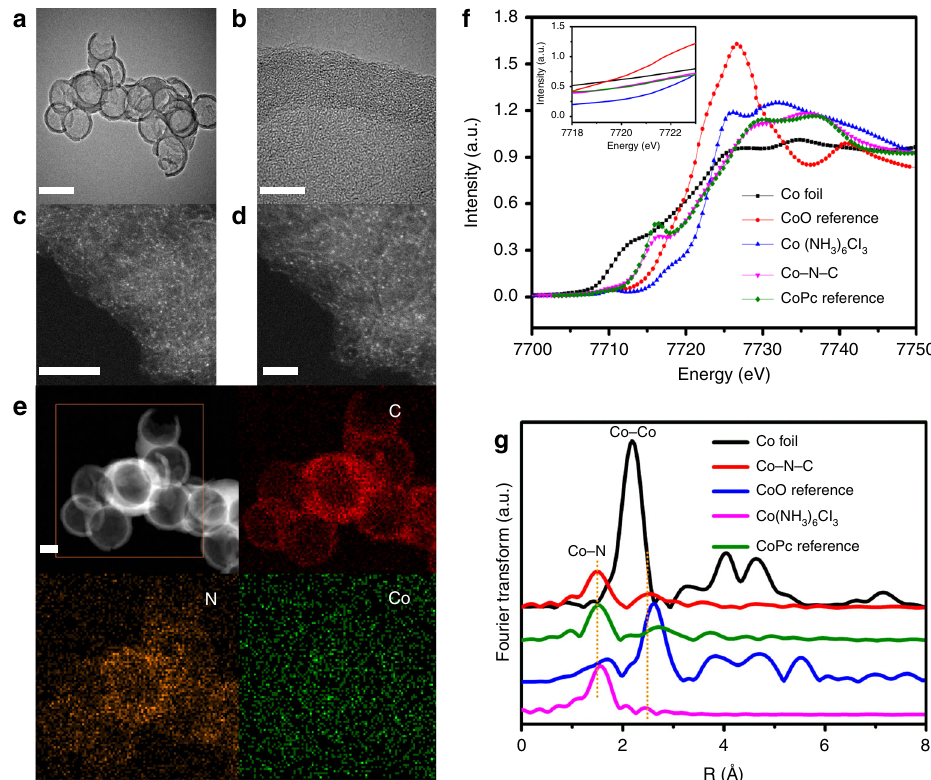
Fig. 1 Physical characterization. a TEM, scale bar: 200 nm; b HR-TEM, scale bar: 10 nm; and c , d Aberration-corrected STEM images; scale bar: 5 nm of c and 2 nm of d ; e HAADF-STEM images of Co – N – C; STEM-mapping of N-K; C-K; Co-K, scale bar: 50 nm; f Normalized Co K-edge XANES spectra (inset is the magni fi ed image of f in the range of 7718 – 7722 eV) and g Co K-edge EXAFS spectra of Co – N – C and